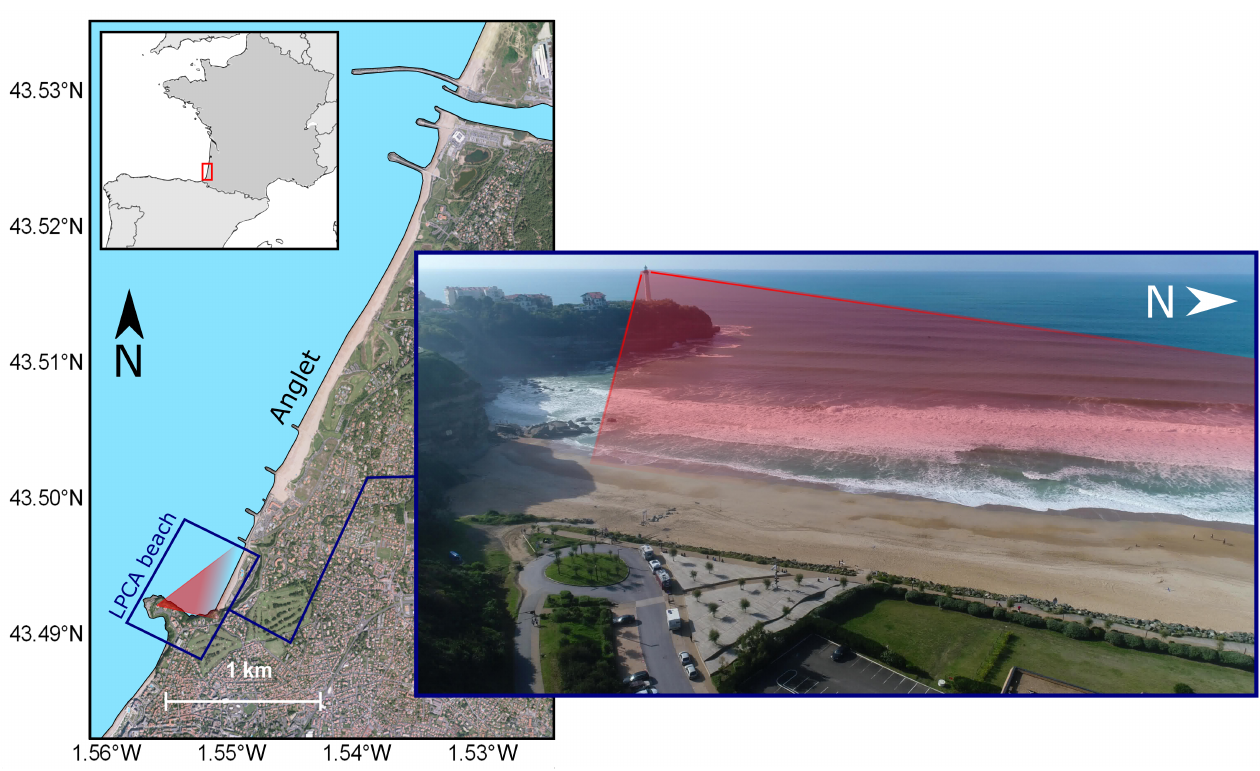
Figure 1. Location of the study site, LPCA beach (Anglet, SW France; blue rectangle). The video- monitoring area is shown in red